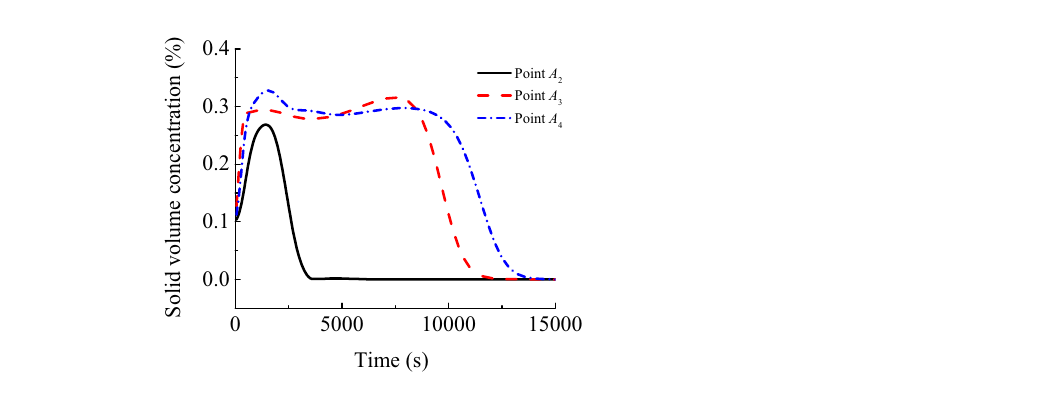
Figure 14. Concentration history curves of different typical